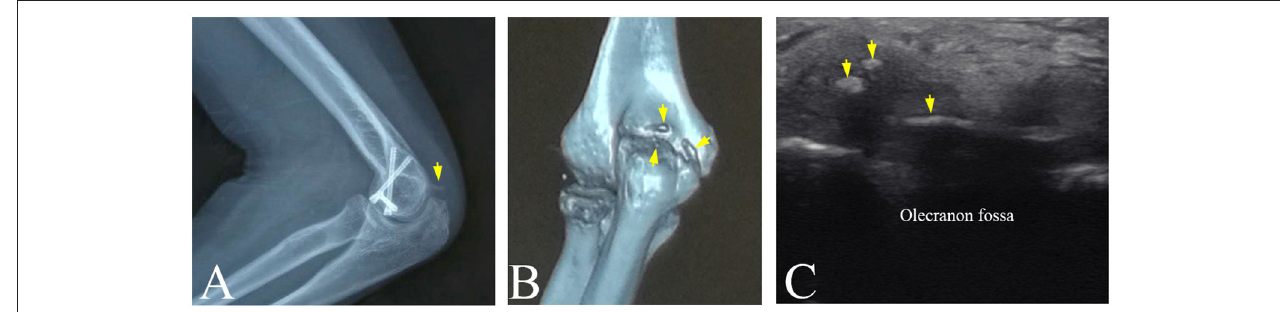
FIGURE 6 | The HO tissues at left elbow joint of participant No. 4 visualized by multi-modality imaging. (A) A spiny HO (arrow) in plain radiograph. (B) A slender HO and two small and granular HOs discovered in CT image (arrows). (C) Two small hyperechoic masses and a slender hyperechoic region (arrows) in triceps brachii in ultrasound